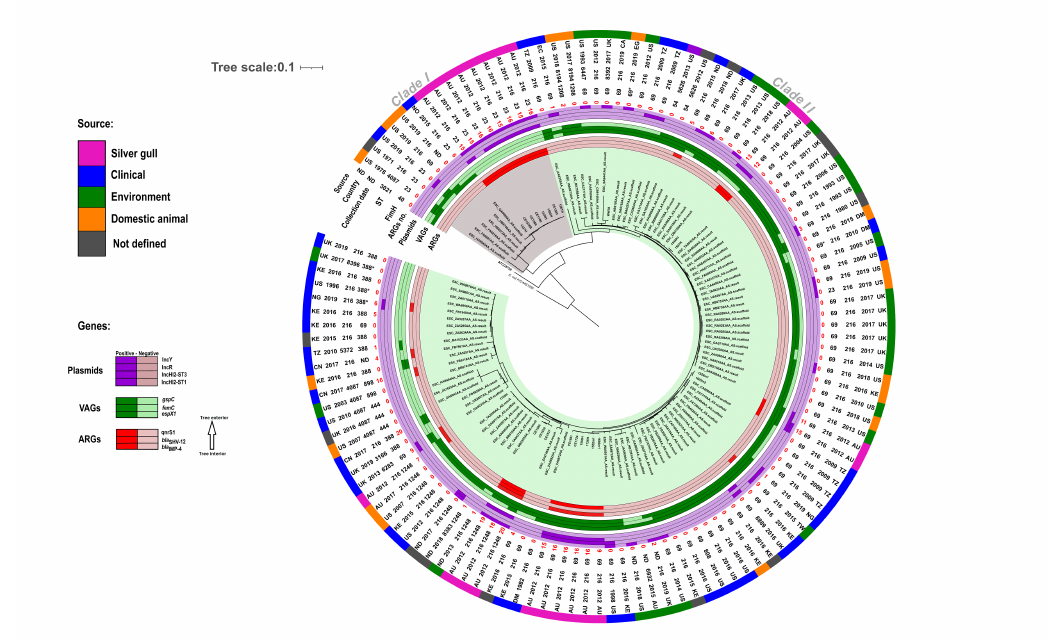
Figure 1. Clonal relationship of Escherichia coli ST216 isolates from silver gulls ( n = 22) at Five Islands and international related isolates ( n =